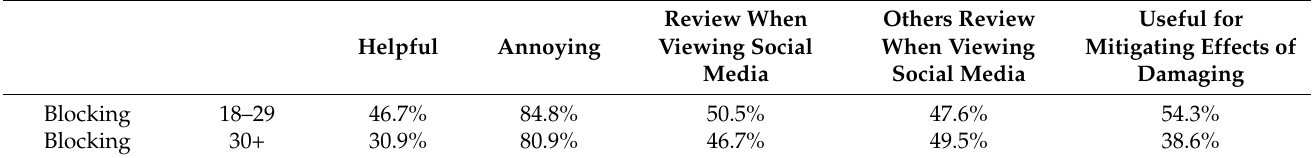
Table 15. Blocking survey results by category and by age group.